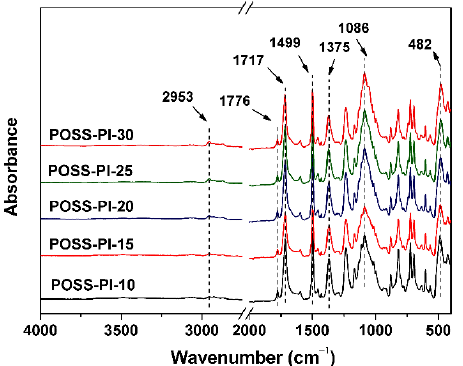
Figure 4. Attenuated total reflectance Fourier transform infrared (ATR-FTIR) spectra of POSS-PI composite films. composite